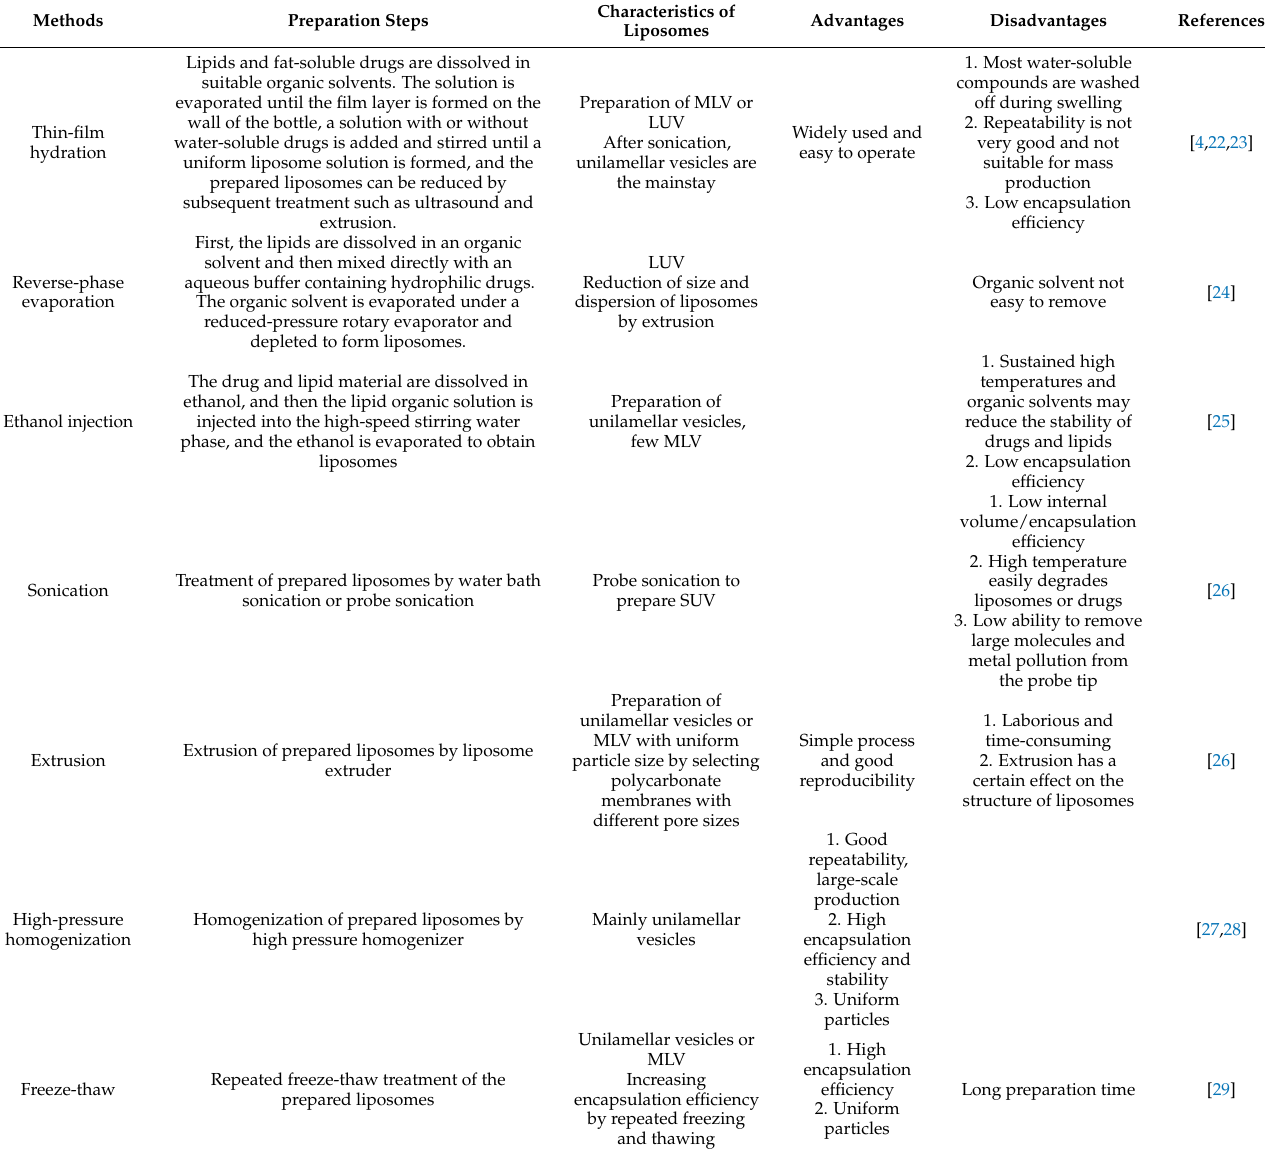
Table 1. Examples of traditional preparation methods of